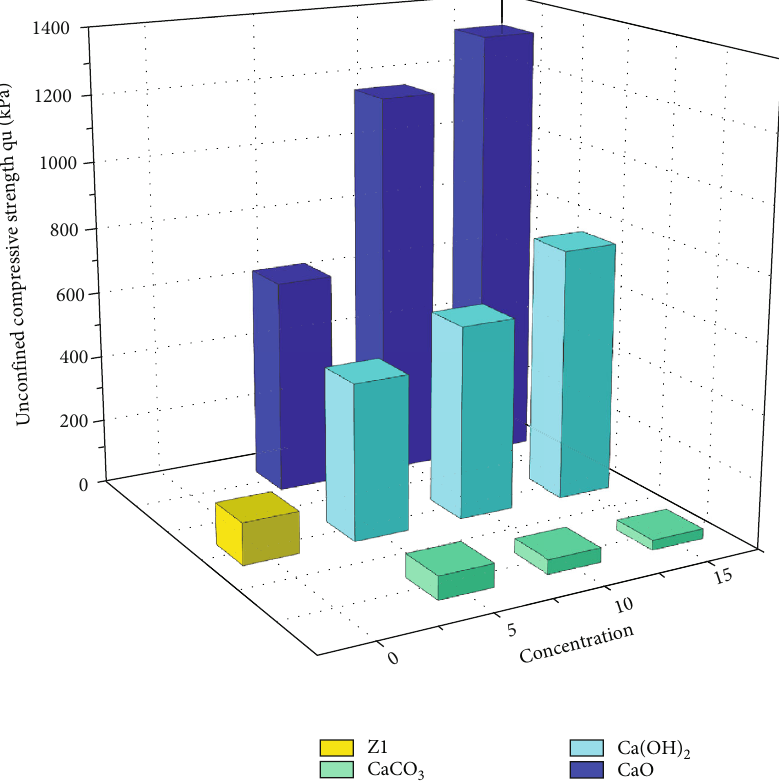
Figure 2: The uncon fi ned compressive strength of each sample at 0.1% Zn 2+